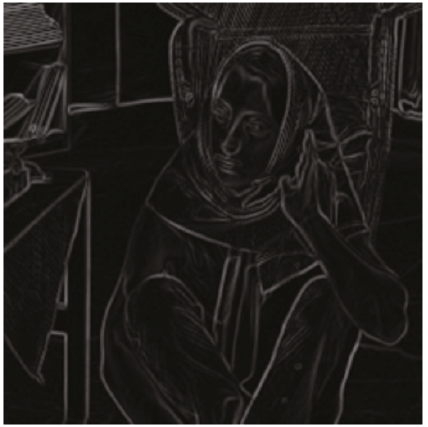
Figure 2: Gradient norm of Barbara color image.